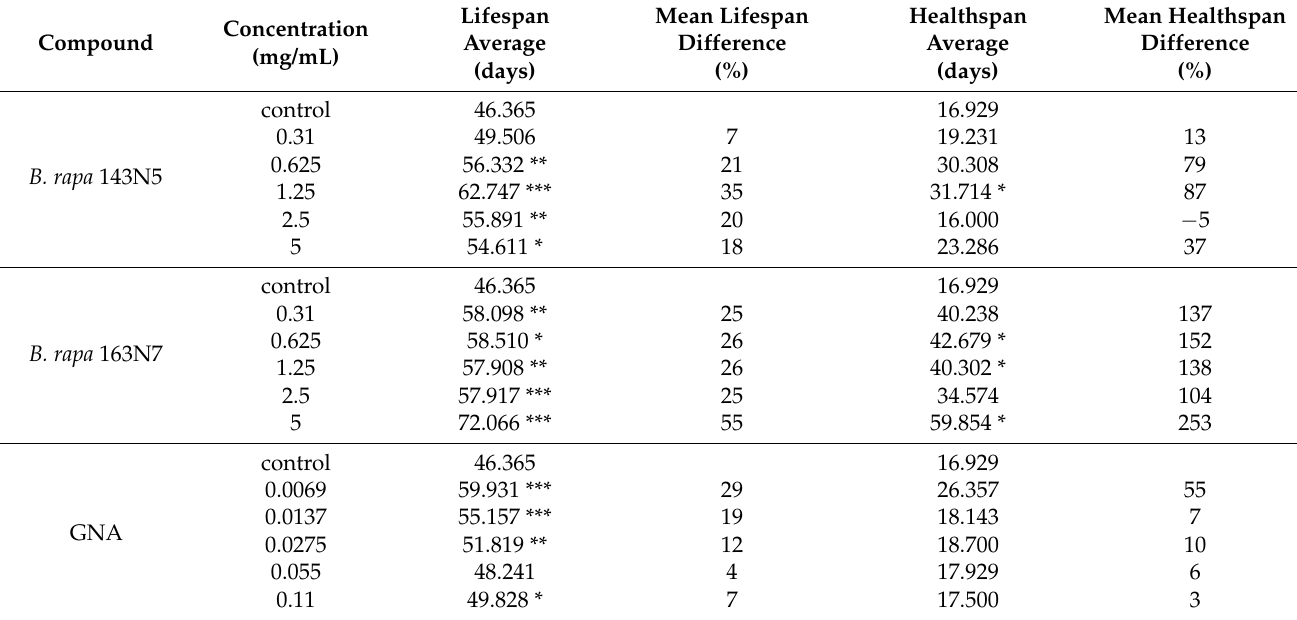
Table 3. Effects of B. rapa 143N5 and 163N7 cultivars and gluconapin (GNA) treatments on the D. melanogaster average lifespan and healthspan